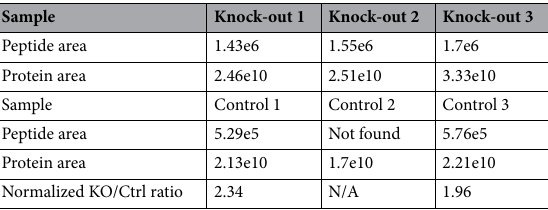
Table 2. Areas and normalized ratios of acetylated CDH1 K135 peptide in control and SIRT6-knockout 293 T cells.